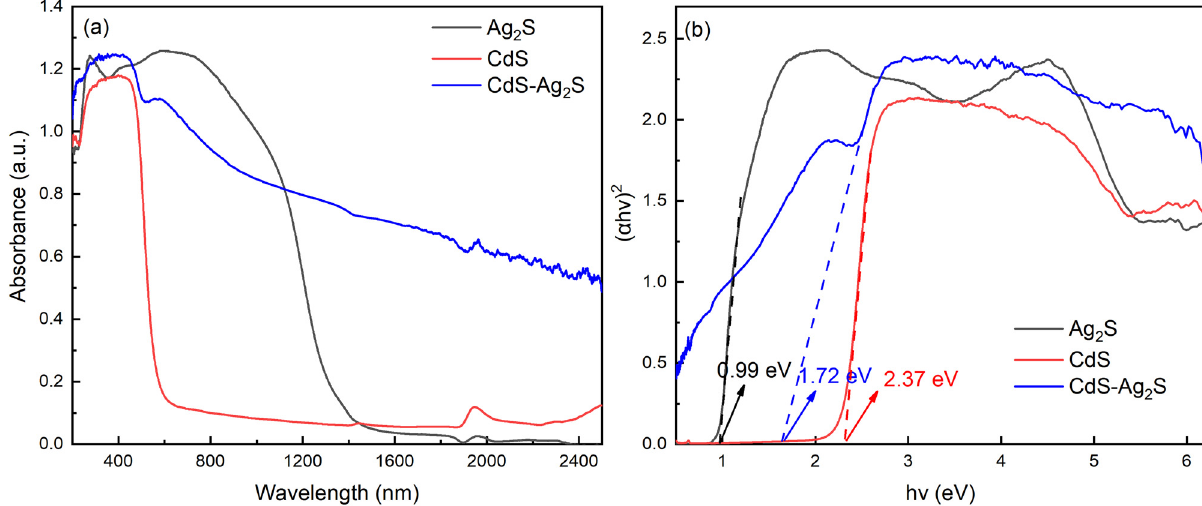
Figure 7: ( a ) UV - Vis absorbance spectra of Ag 2 S, CdS, and CdS – Ag 2 S; ( b ) plots of ( α hv ) 2 versus energy ( hv ) of Ag 2 S, CdS, and CdS – Ag 2